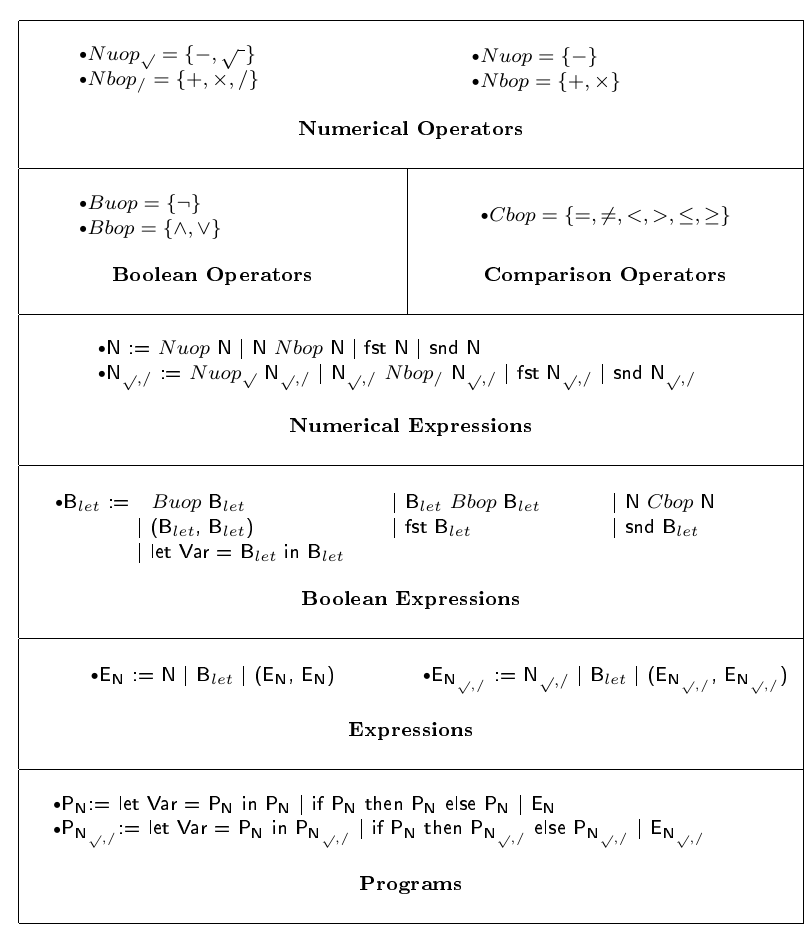
Fig. 1. Target language